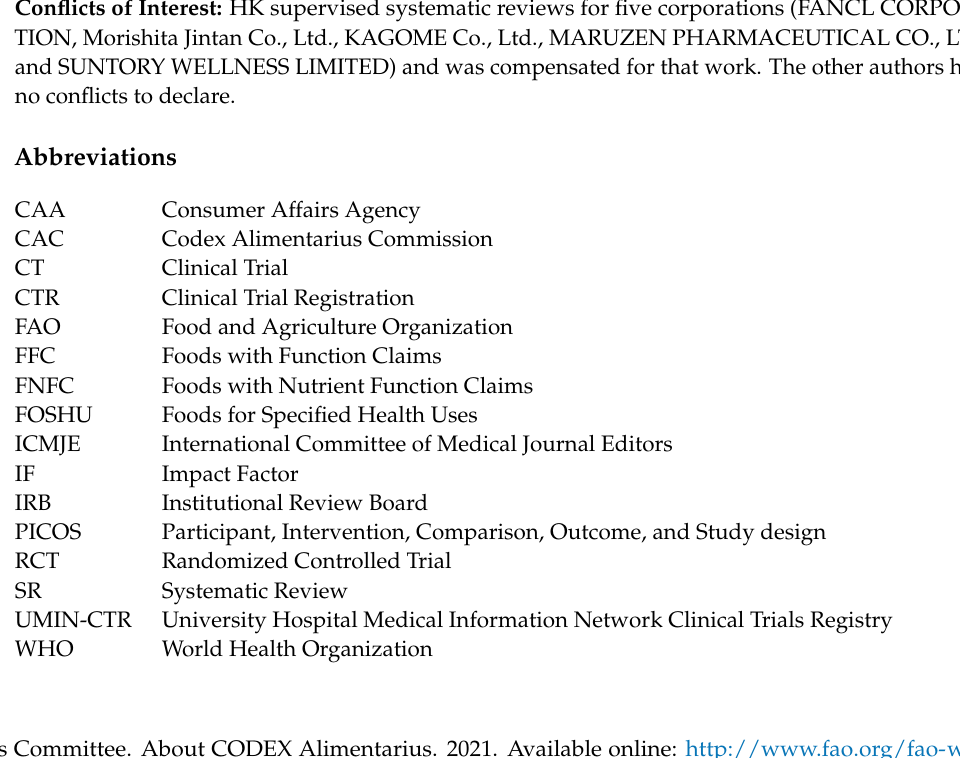
Table S2: Category of first author, language, and protocol